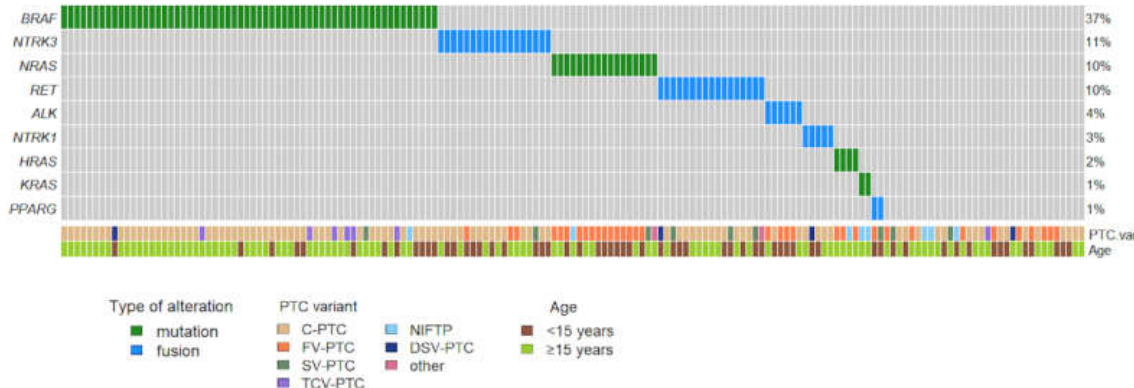
Figure 1. Oncoplot showing the prevalence and type of molecular alterations detected in 163 pediatric PTCs. Sidebars show the PTC variant and the age class of patients. Abbreviations: C-PTC, classical papillary thyroid carcinoma; FV-PTC, follicular variant papillary thyroid carcinoma; SV-PTC, solid variant papillary thyroid carcinoma; TCV-PTC, tall cell variant papillary thyroid carcinoma; DSV-PTC, diffuse sclerosing variant papillary thyroid carcinoma; NIFTP, noninvasive follicular neoplasm with papillary-like nuclear features.